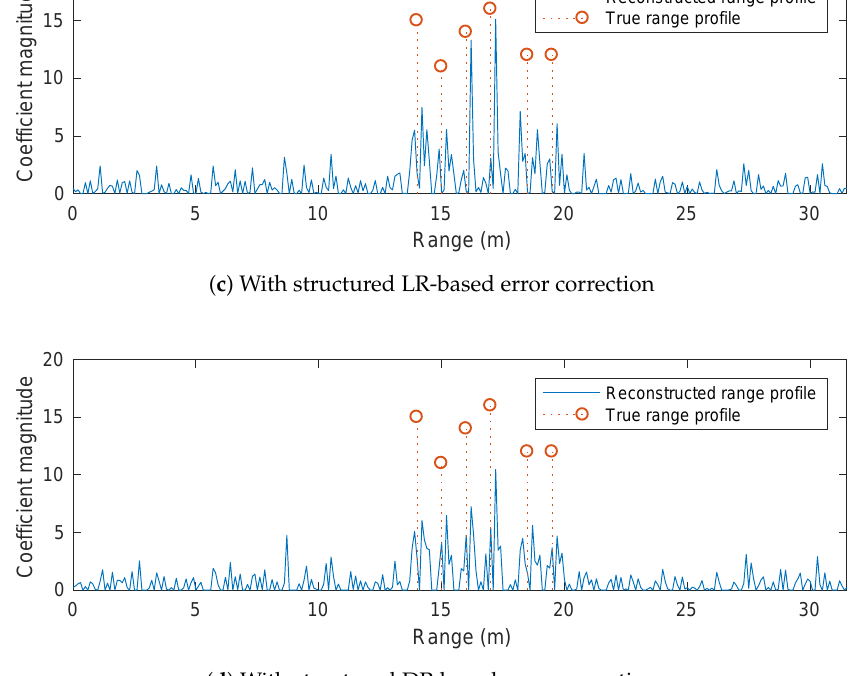
( d ) With structured DP-based error correction Figure 5. Performance of l 1 -norm regularised optimisation solver with phase error